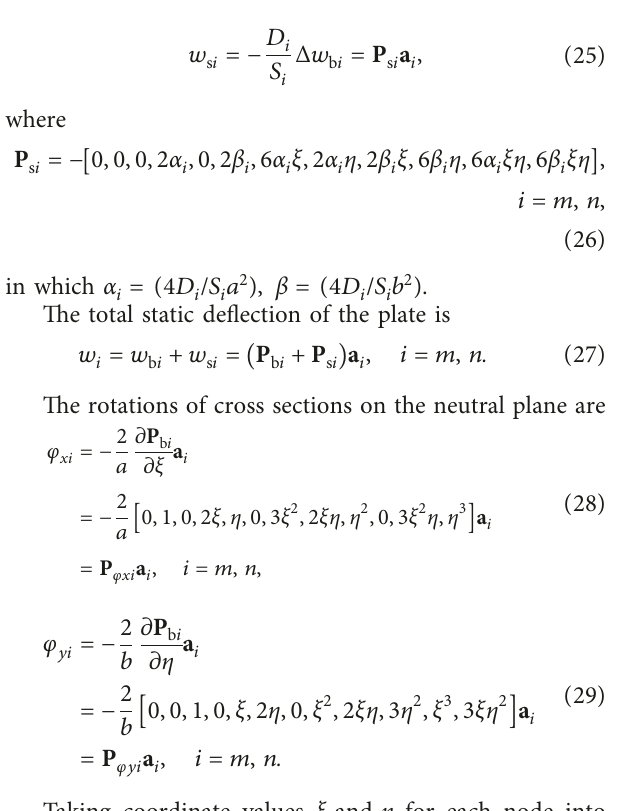
Figure 2: A two-layer composite plate